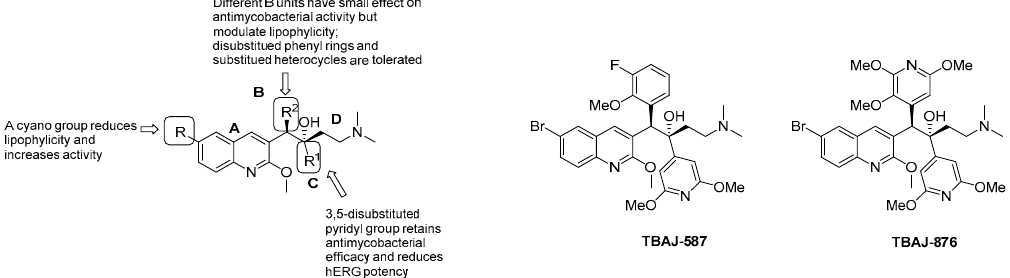
Figure 18. SAR for 2nd generation DARQs and chemical structures of the two pre-clinical candidates TBAJ-876 and TBAJ-587. Table 1. clogP, hERG activity, antimycobacterial e ffi cacies in vitro and in vivo, and IV mouse clearance for BDQ and its improved analog